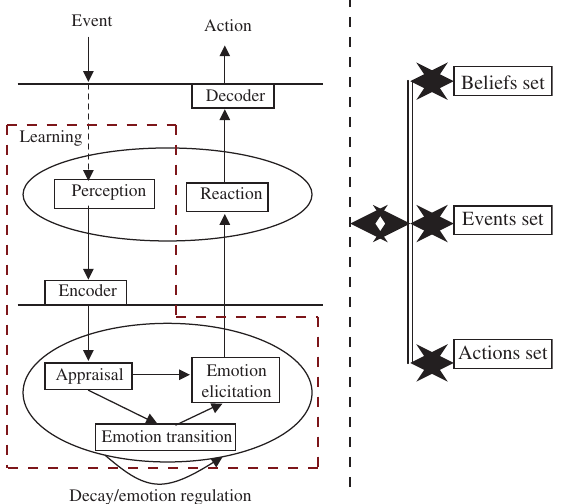
Figure 2. Architecture of